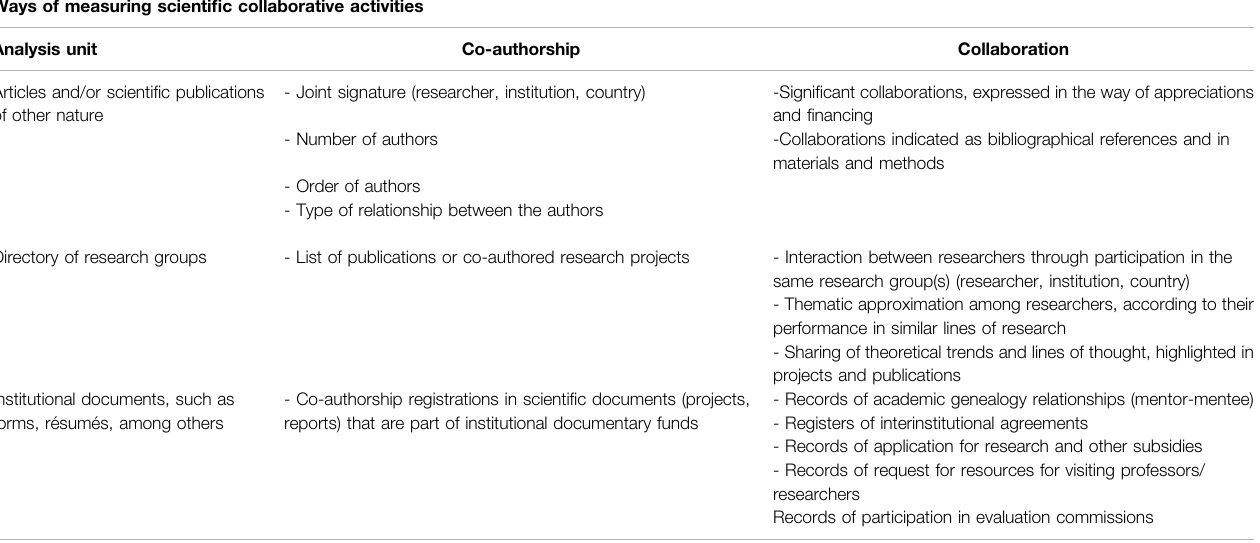
TABLE 2 | Methods and measurement units of collaborative activity in